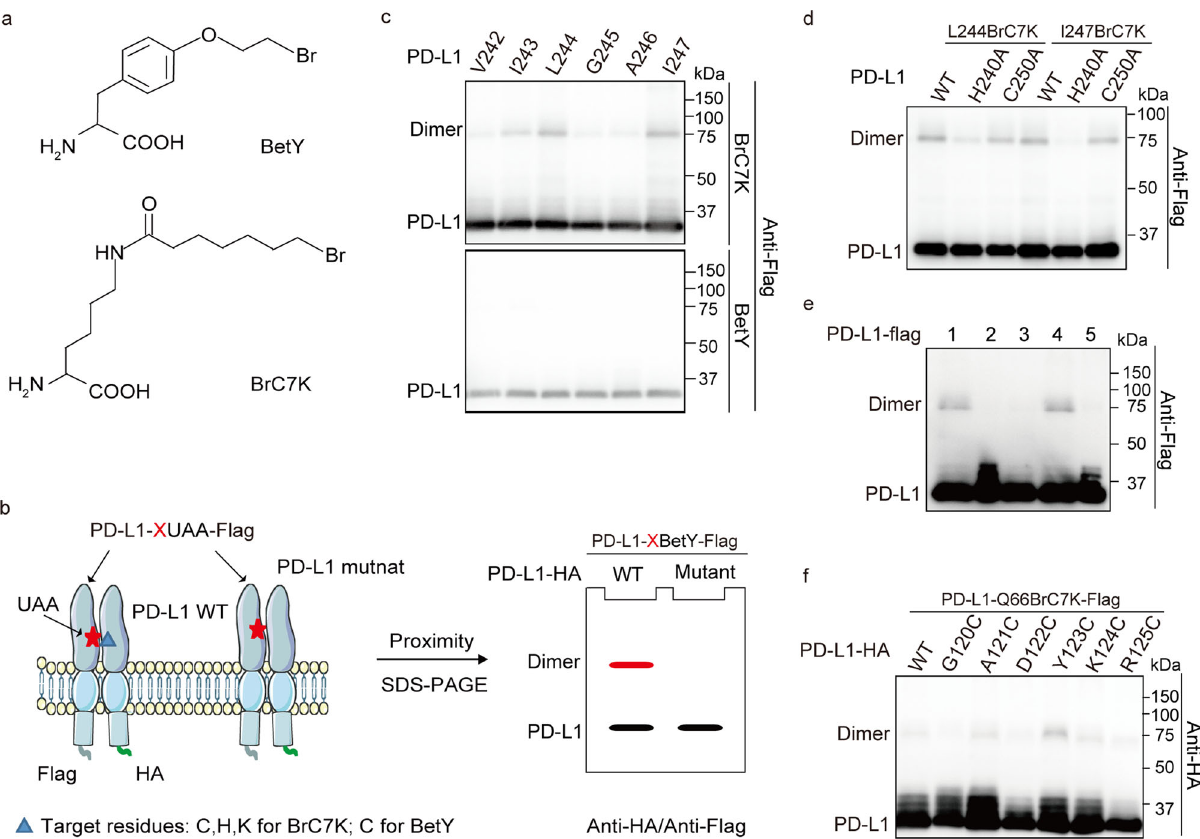
Fig. 3 PD-L1 asymmetrically homodimerized. a Structural formula of proximity-enabled UAAs, BrC7K, and BetY. b Schematic diagram of mapping interacting residue pairs using the chemical cross-linking UAAs. Red stars represent the proximity-enabled UAAs, namely BrC7K/BetY. BrC7K/BetY selectively reacts with targeted amino acids (blue triangle) to form covalent complexes which are destroyed by targeted amino acids mutation. c BrC7K incorporated into the transmembrane domain of PD-L1 capture its homodimers. PD-L1-Xtag-Flag plasmid was cotransfected with pHY-XYRS or pHY- BrC7KRS to incorporate the BetY or BrC7K individually. Samples were collected for anti-Flag immunoblotting analysis. Residues replaced by BrC7K/BetY are indicated in the upper row. d BrC7K at L244 and I247 of PD-L1 interact with H240 residues. PD-L1-L244/I247BrC7K-Flag with or without the H240A/ C250A mutation were expressed in HEK293T cells. e D284 in the intracellular domain of PD-L1 interacts with C272. BrC7K were incorporated into D284 of PD-L1 or PD-L1 mutants. Lane 1: PD-L1-D284BrC7K-Flag; Lane 2: PD-L1-C272A-Flag; Lane 3: PD-L1-C272A-D284BrC7K-Flag; Lane 4: